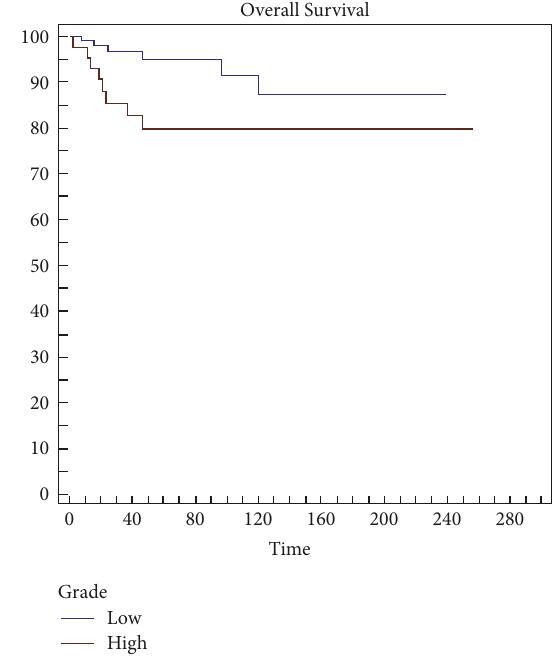
Figure 1: Margins represent a significant risk factor ( 𝑝 = 0,002) in overall survival (OS).